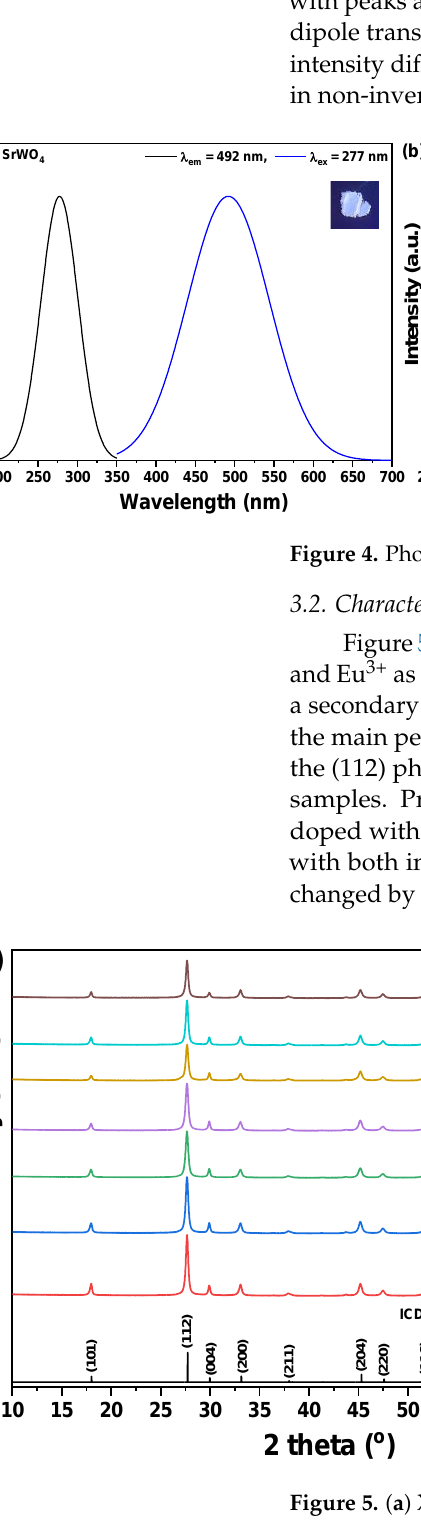
Figure 6. FE-SEM images and EDS mapping analysis of SrWO 4 :[Eu 3+ ]/[Tb 3+ ]. Figure 7(a) shows the emission spectrum of the SrWO 4 :[Eu 3+ ]/[Tb 3+ ] phosphor pow- der co-doped with changing Eu 3+ ion concentrations, while the Tb 3+ ion concentration re- mained fixed. The emission spectra of the two rare earth ions were shown when excited at a wavelength of 254 nm, as the doping concentration of Eu 3+ increased. Green at 544 nm and orange – red at 614 nm were simultaneously observed. As the concentration of Eu 3+ ions increased, the intensity of the green emission by Tb 3+ ions decreased, which means that the emission energy was converted from Tb 3+ ions in the host lattice to Eu 3+ ions (Fig- ure 7(b)). The energy transfer efficiency from Tb 3+ to Eu 3+ ions can be expressed by Equa- tion (1) [31].